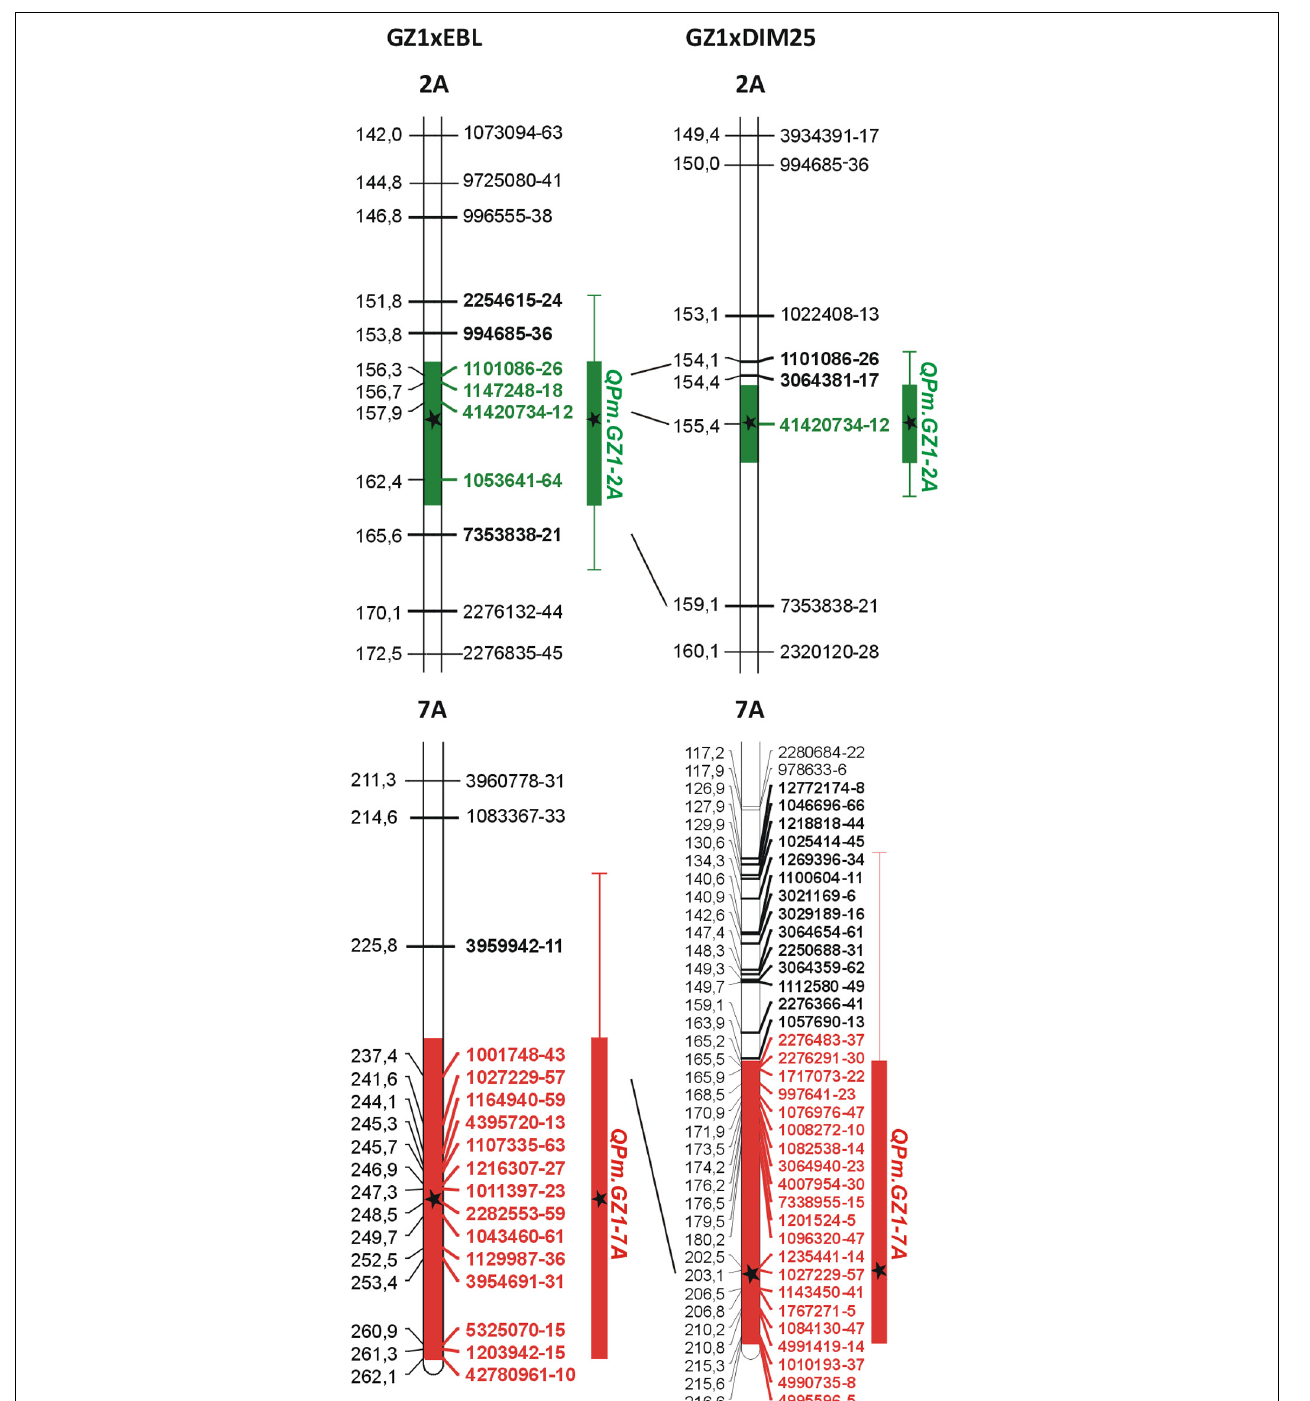
FIGURE 2 | Highly significant QTLs for powdery mildew resistance mapped in the GZ1 × EBL and GZ1 × DIM25 mapping populations. Only relevant parts of chromosomes with mapped QTLs are shown. The genetic distances (left side) are in cM (Kosambi). In the GZ1 × EBL , the QPm.GZ1-2A was in the region from 155.55 to 163.75 cM (8.2 cM; green bar) of chromosome 2AL with the QTL peak at 159.65 cM (black star). This region comprises 4 markers (bold green). The confidence interval extended the area from 151.6 to 167.7 cM (16.1 cM; thin green line). This 16.1 cM long region comprises 7 markers (bold). In the GZ1 × DIM25 , QPm.GZ1-2A was in a 1.54 cM long region (154.67–156.21 cM; green bar) with one marker (bold green). The QTL peak is at 155.44 cM (black star) of chromosome 2AL. The confidence interval extended the area of this QTL to 3 cM (153.9–156.9 cM; thin green line and 3 markers in bold). In the GZ1 × EBL , QPm.GZ1-7A was in a 28.96 cM long region (red bar) of the chromosome 7AL and comprises 14 markers (bold red). Confidence interval extends the area to 42.3 cM (thin red line) with 15 markers (bold). The QTL peak is at 248.12 cM (black star). In the GZ1 × DIM25 , the QPm.GZ1-7A was in a 52.34 cM long region (red bar, 21 markers) of the chromosome 7AL, with the confidence interval of 90.8 cM (red thin line) comprising 35 markers (bold) with the QTL peak at 204.25 cM (black star). The shared markers are indicated by lines connecting the maps. Frontiers in Plant Science |